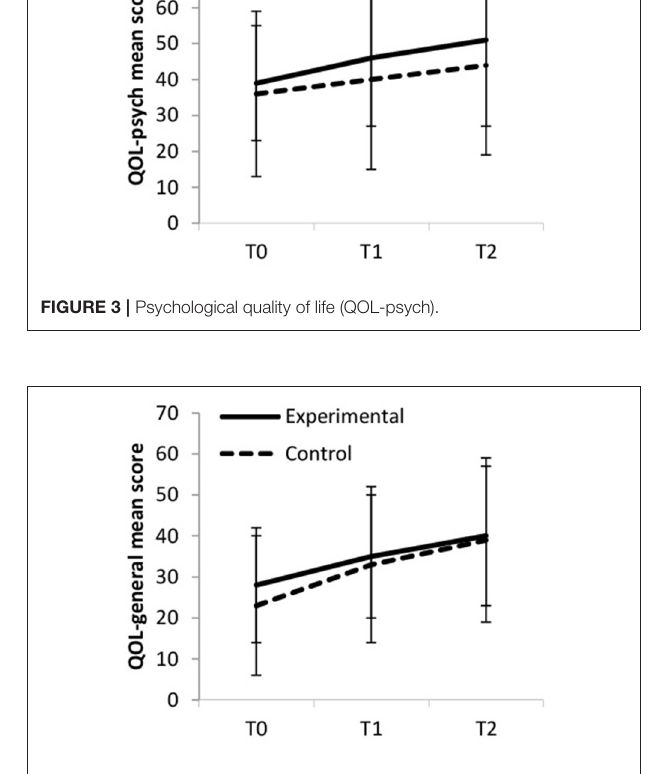
FIGURE 4 | General quality of life (QOL-general).